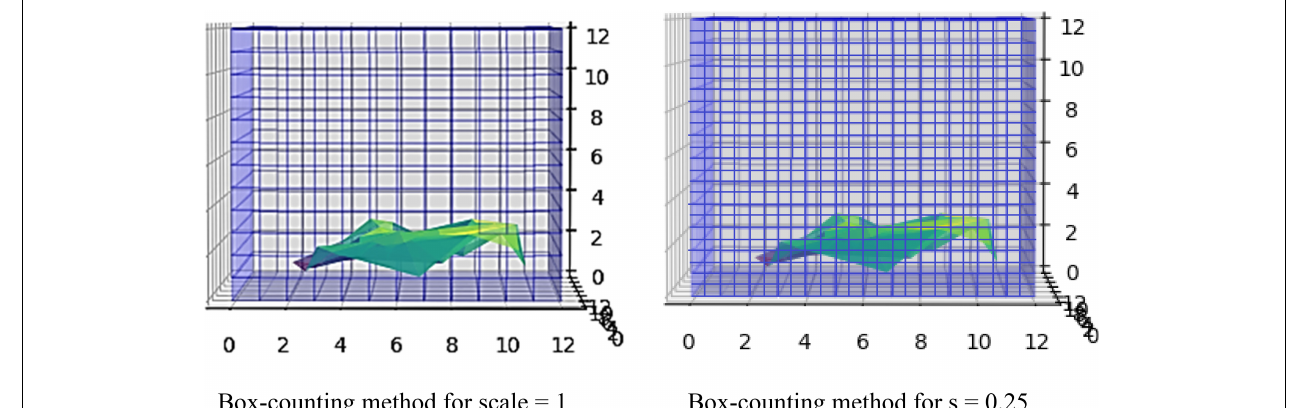
FIGURE 3 | The algorithm calculating FD in 3D examples.